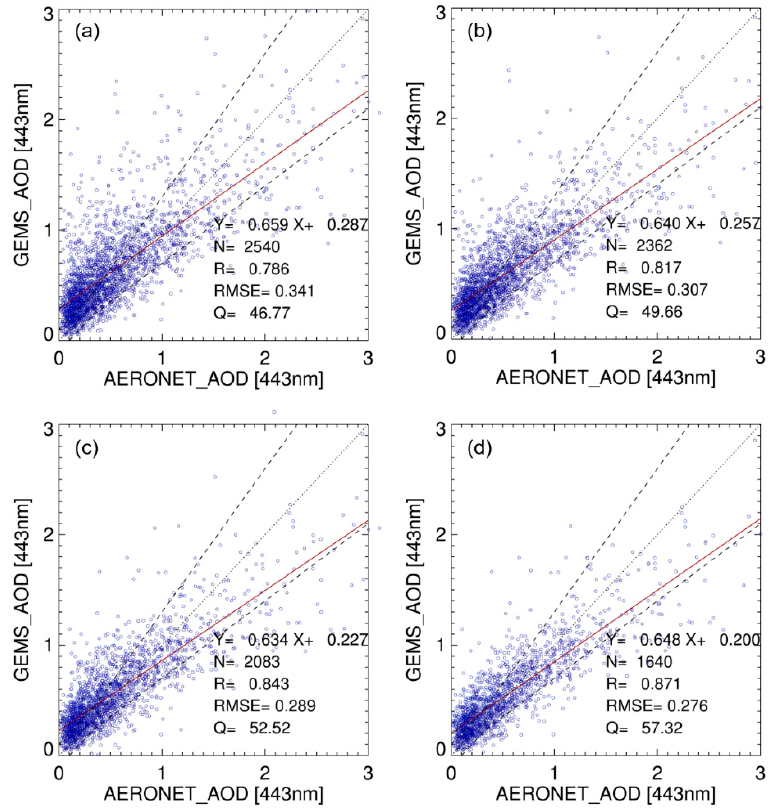
Figure 4. Validation of GEMS AOD with OMI L1B and Aerosol Robotic Network (AERONET) L2 direct-measurement data, 2005–2007, with MODIS cloud fractions of ( a ) <80%; ( b ) <60%; ( c ) <40%; ( d ) <20%. Dotted and dashed lines indicate 1:1 line and expected error of AOD (30% or 0.1; Ahn et al. [65]), respectively. Red line is the linear fitting line for validation results. Corresponding slope ( 𝐴 ) and offset ( 𝐵 ) for red line are presented in each figure in 𝑦 = 𝐴𝑥 + 𝐵 format.